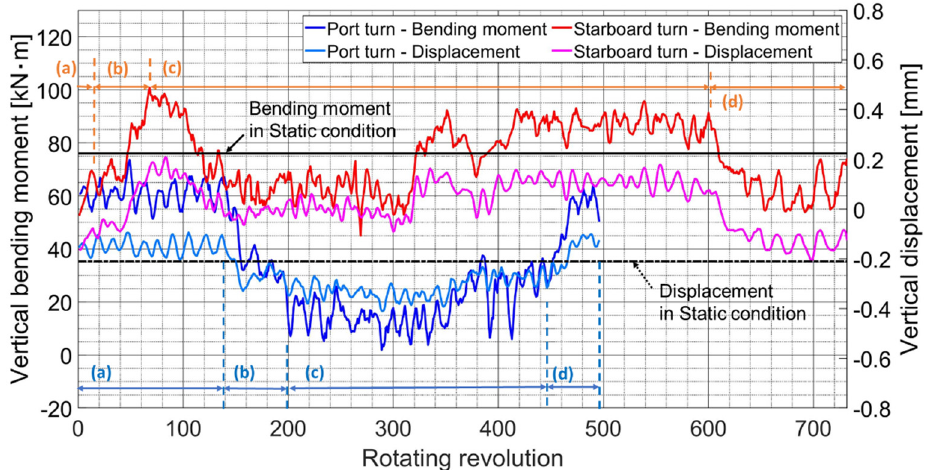
Figure 23. Comparison of behaviors between the port turn and the starboard turn under the normal ballast condition. Stage (a): Rudder angle 0-degree: going straight ahead at the NCR (begin). Stage (b): The rudder angle changes from 0 to 12-degree (port, starboard). Stage (c): Rudder angle 12-degree: the ship’s heading is gradually changing. Stage (d): Rudder angle 0-degree: going straight ahead at the NCR (end).